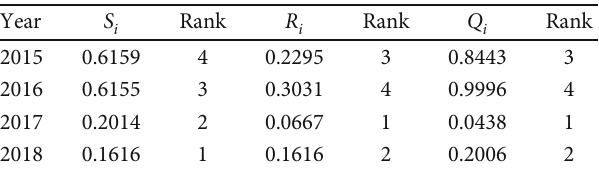
Table 18: S subsystem.